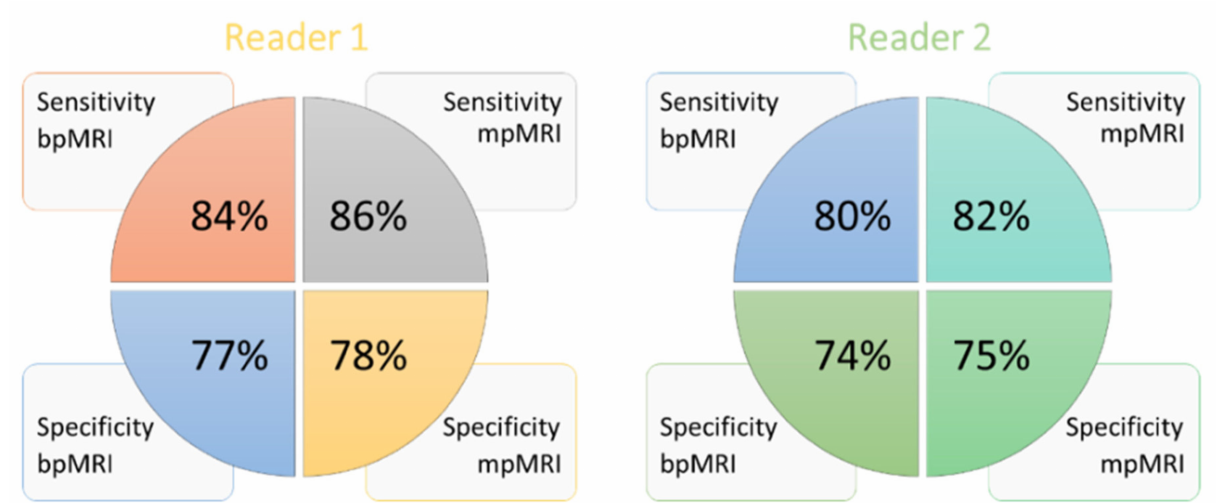
Figure 2. Sensitivity and specificity performance of each reader in bpMRI and mpMRI. Reader 1 had a sensitivity and specificity of 84% and 77% for bpMRI, respectively, versus 86% and 78% for mpMRI. Reader 2 had a sensitivity and specificity of 80% and 74% for bpMRI, respectively versus 82% and 75% for mpMRI. bpMRI: biparametric MRI, and mpMRI: multiparametric